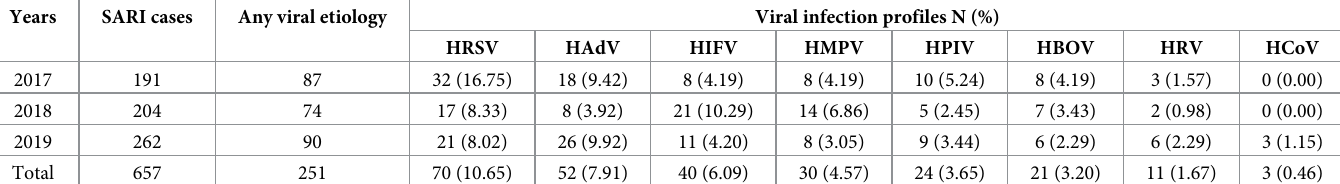
Table 1. Viral infection profiles in hospitalized patients with SARI in Huzhou, 2017–2019.